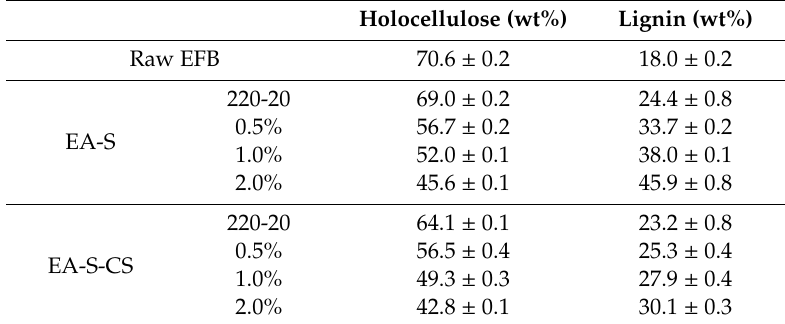
Table 3. Component analysis of acid pretreated EFB solid